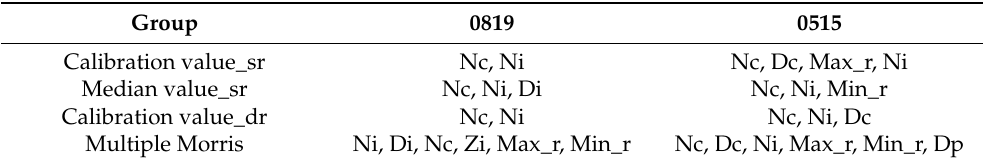
Figure 3. Comparing three sample techniques’ parameter sensitivity using the Morris screening method: ( a ) Average flow parameter sensitivity for rainfall event 0819; ( b ) Max flow parameter sensitivity for rainfall event 0819; ( c ) Average flow parameter sensitivity for rainfall event 0515; ( d ) Max flow parameter sensitivity for rainfall event 0515. The gray dashed line denotes the parameter sensitivity threshold. Table 3. Three sampling methods: SA screening sensitive parameters and a combined relatively sensitive